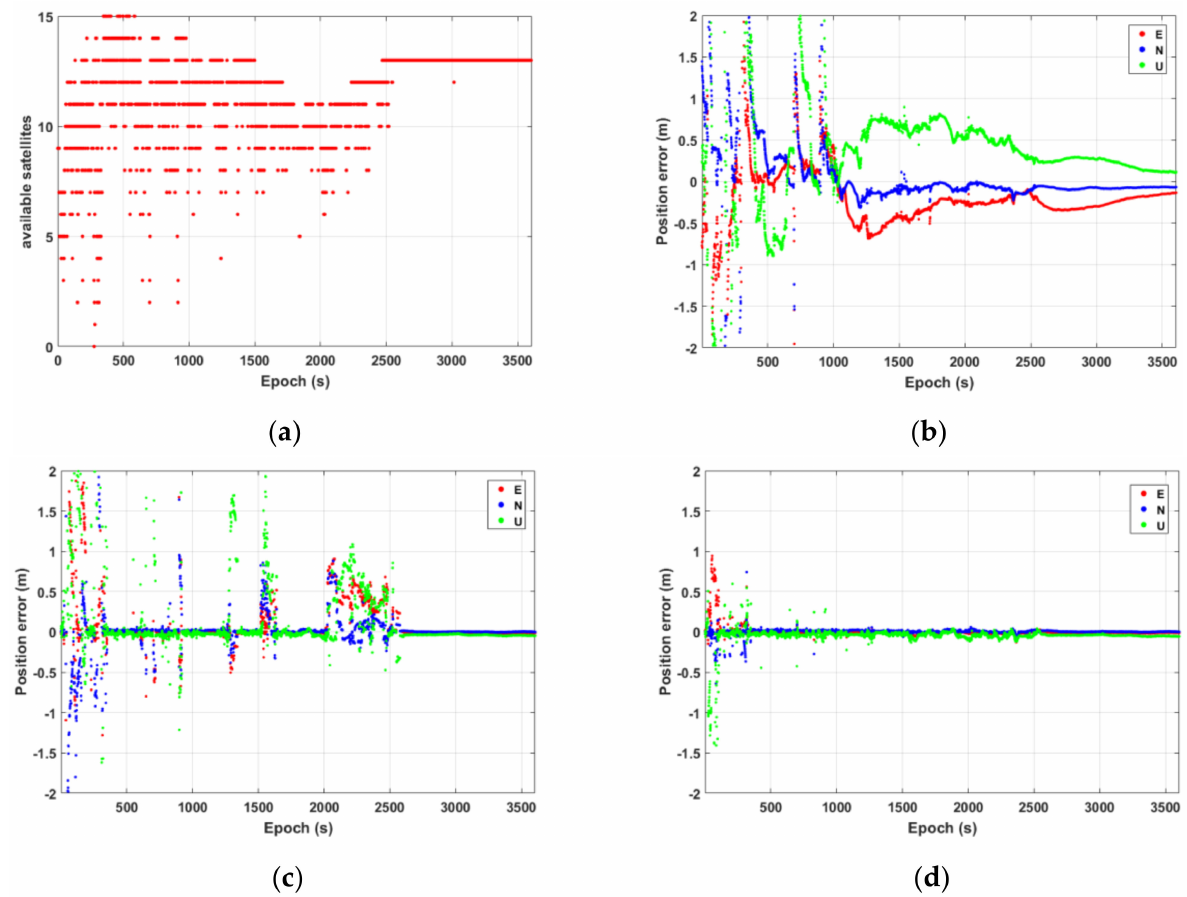
Figure 6. ( a ) The number of available satellites in experiment A. ( b ) Position errors sequence of float PPP. ( c ) Position errors sequence of PPP − RTK. ( d ) Position errors sequence of TC PPP −